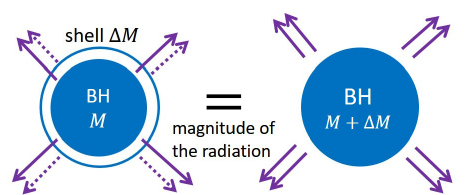
Figure 6. Statement of step 2. The total magnitude of the pre-Hawking radiation (dashed arrows) from the shell of ∆ M and the usual Hawking radiation (solid arrows) from the black hole is equal to that of the usual Hawking radiation (solid arrows) from a larger black hole of mass M + ∆ M